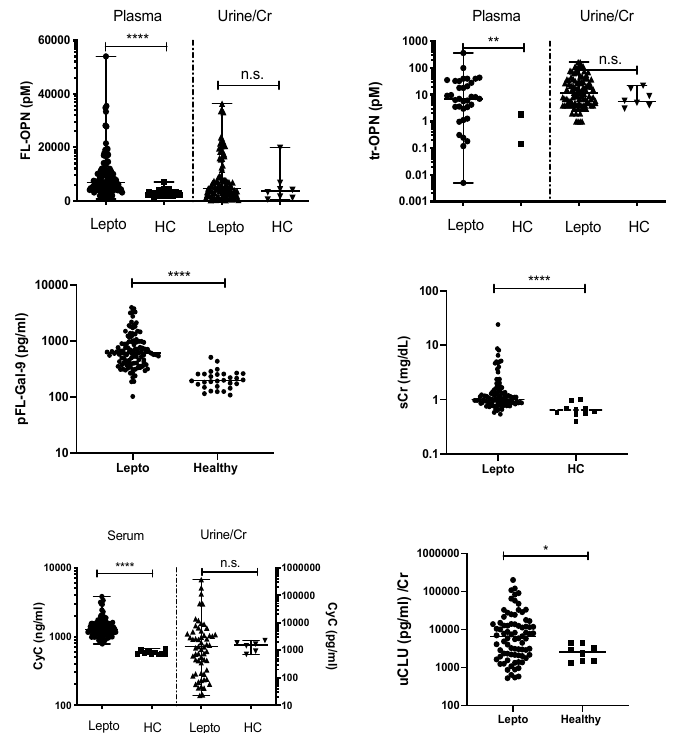
Figure 1. The levels of biomarkers in the plasma (p), serum (s), and urine (u) were compared between